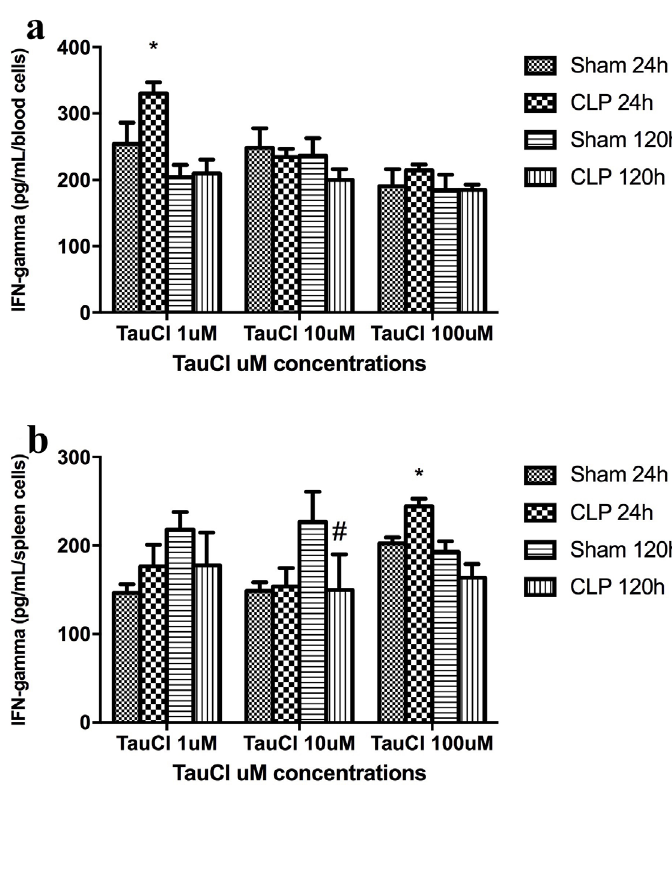
Figure 5. The effect of TauCl on the production of the pro-inflammatory mediator, TNF-α. Lymphocytes (1x106 cells/mL) were preincubated with TauCl (1, 10 or 100 uM) for 1 hour. After this, supernatants were collected and TNF-α was measured by ELISA for (a) blood and (b) spleen. Results are expressed as means ± SD. * = P < 0.05 compared with sham rats at 24 hours